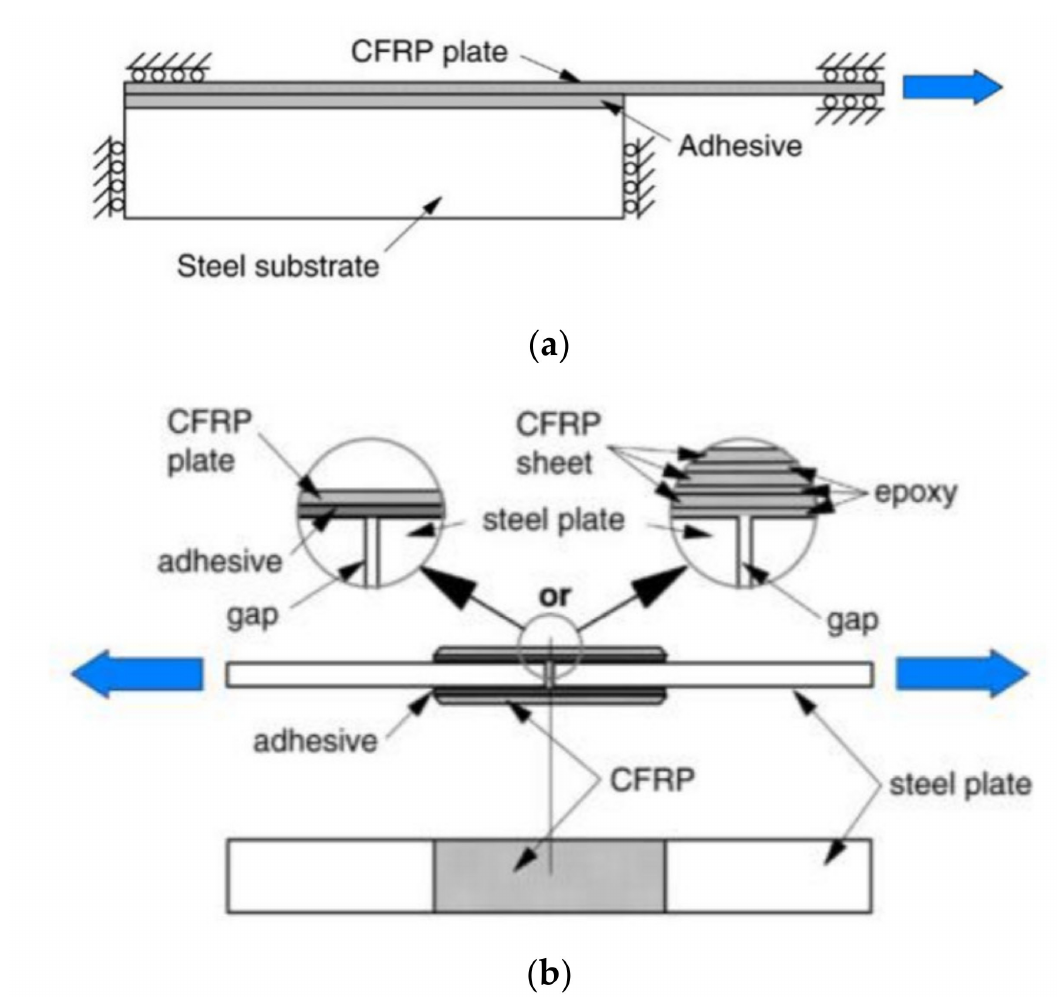
Figure 1. Test configurations of CFRP/steel joints ( a ) a single lap (single composite patch) shear joint. ( b ) a double lap shear joint [3]; used with permission from Engineering structures, Elsevier,